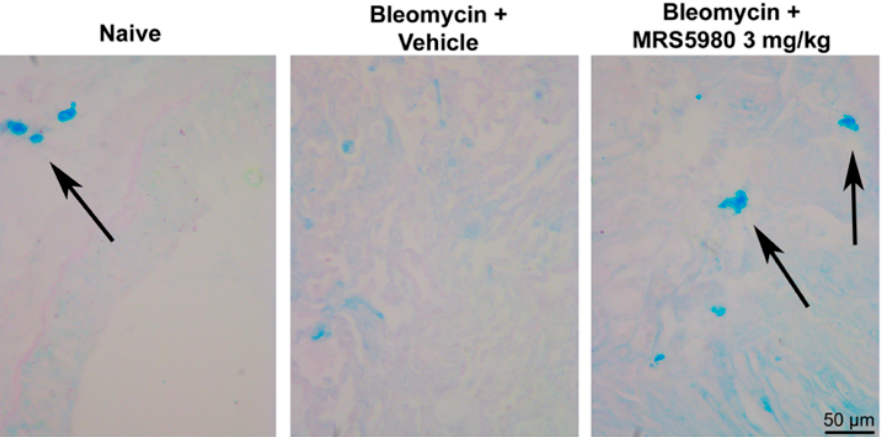
Figure 6. Determination of mast cell degranulation. Representative micrographs of Astra Blue- stained lung sections (magnification 40 × ) in naïve animals and animals treated with bleomycin plus vehicle or MRS5980, 3 mg/kg. Black arrows indicate mast cells.